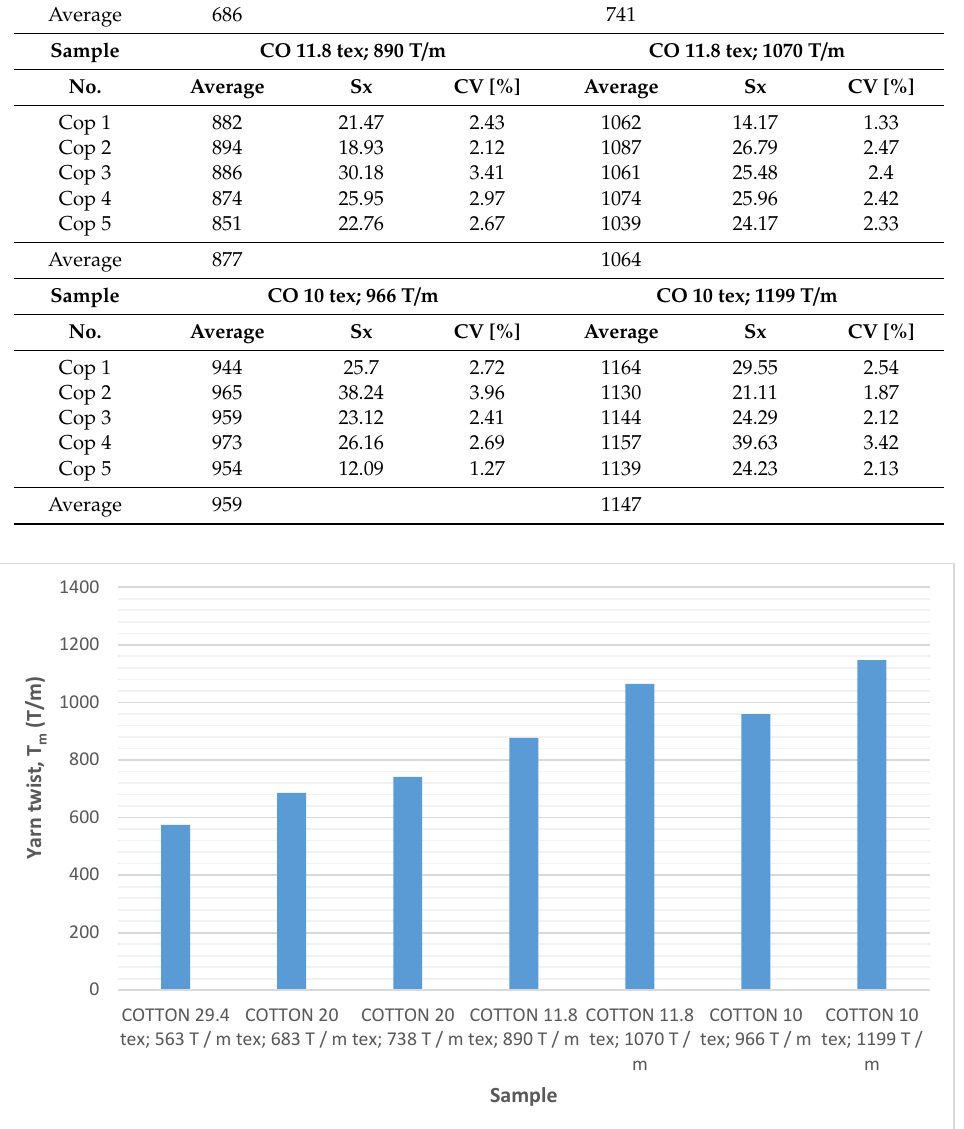
Figure 4. Average yarn twist of the analyzed yarns.